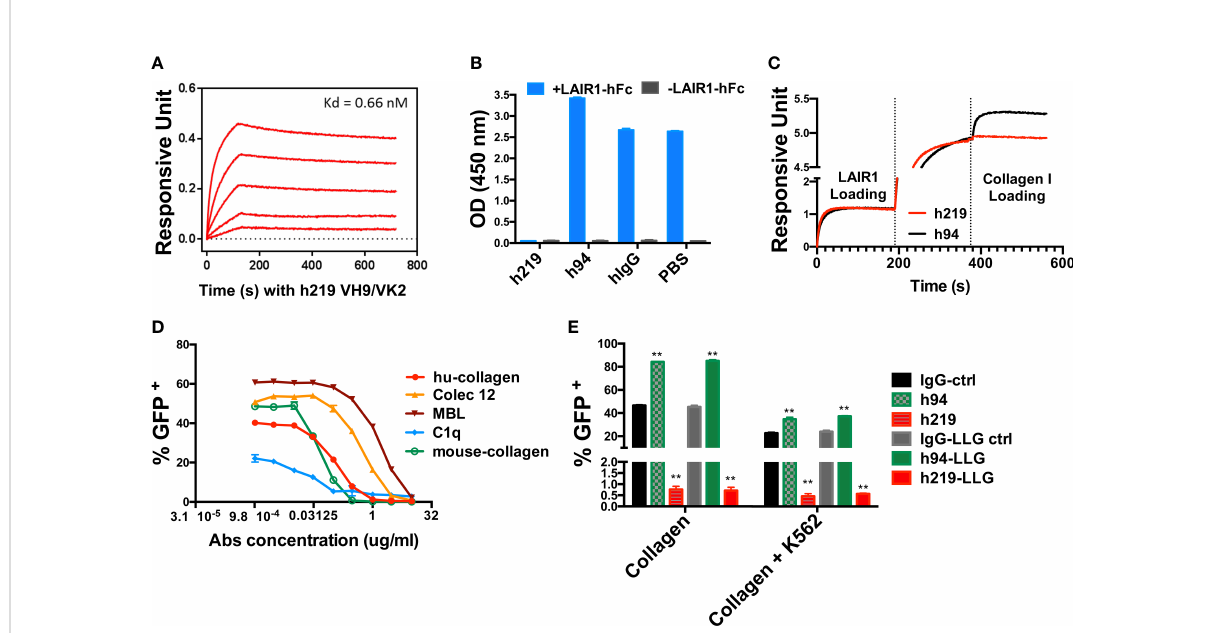
FIGURE 1 Humanized 219 (h219) is an antagonist anti-LAIR1 monoclonal antibody. (A) Af fi nity of h219 (VH9/VK2) to human LAIR1 was determined by Octet RED96. ForteBio ’ s data analysis software was used to fi t the data to a 1:1 binding model to extract an association rate and dissociation rate. The Kd was calculated using the ratio k dis /k on . (B) h219 blocks LAIR1 and collagen I interaction in ELISA. Collagen I was coated on 96-well plate at 1 m g/ml. Pre-incubated LAIR1-hFc (2 m g/ml) and h219, h94, or hIgG (5 m g/ml) were added to the plate after blocking with 5% non-fat milk. HRP conjugated goat anti-human IgG Fc was used to detect the binding of LAIR1-hFc to Collagen I. (C) h219 blocks LAIR1 and Collagen I interaction performed by Octet RED96. NTA biosensors were used to capture his tagged human LAIR1 recombinant protein (20 m g/ml). After loading of h219 or control antibody h94 (40 m g/ml), the collagen I (80 m g/ml) binding signal was detected. (D) h219 blocks LAIR1 activation induced by the indicated molecules as determined by the LAIR1 chimeric receptor reporter cell assay. (E) Comparison of the activities of control, h94, and h219 antibodies with wildtype Fc or with LALA-PG mutation in Fc that does not have Fc-mediated effector function (see Supplementary Figure 7) to block collagen-induced LAIR1 activation. Immobilized collagen (left) or collagen stably expressed on K562 cells (right) was used to induce LAIR1 activation in LAIR1 chimeric receptor reporter cells. One-way ANOVA test for IgG-ctrl, h94, and h219, p<0.0001. One-way ANOVA test for IgG- LLG ctrl, h94-LLG, and h219-LLG, p<0.0001, ** p <